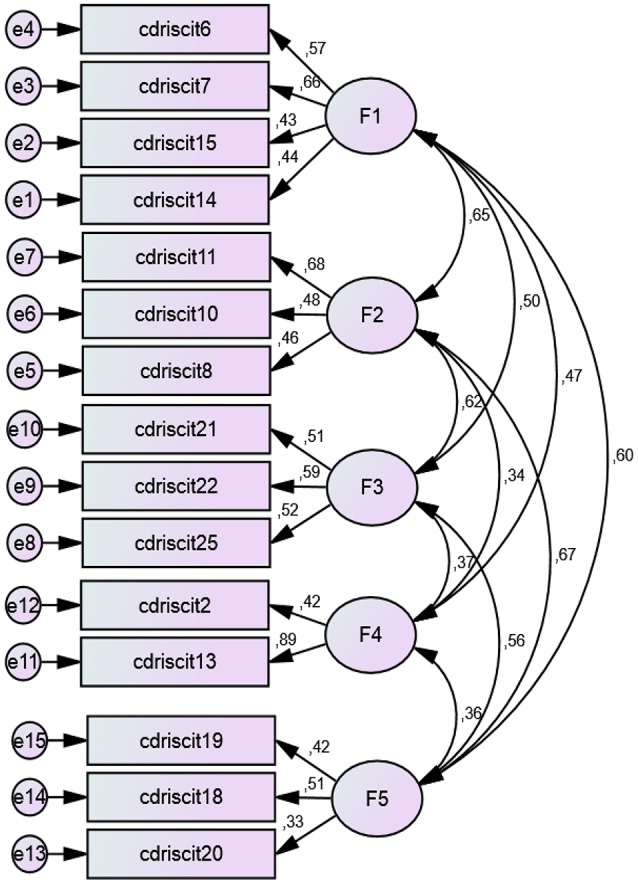
Confirmatory factorial analysis of CD-RISC scale (n = 365). For the items, see Annex in Supplementary Meterial.